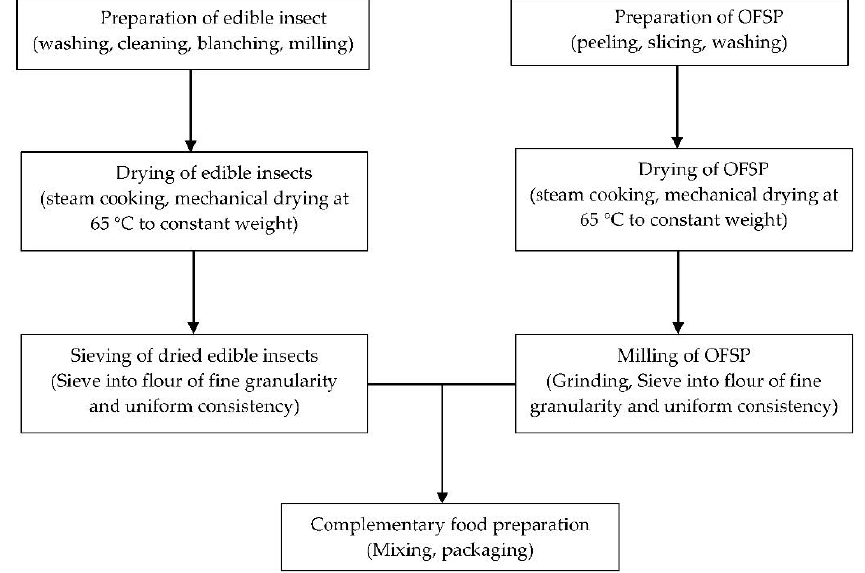
Figure 1. Preparation of orange–fleshed sweet potato (OFSP) complementary foods enriched with edible insects.